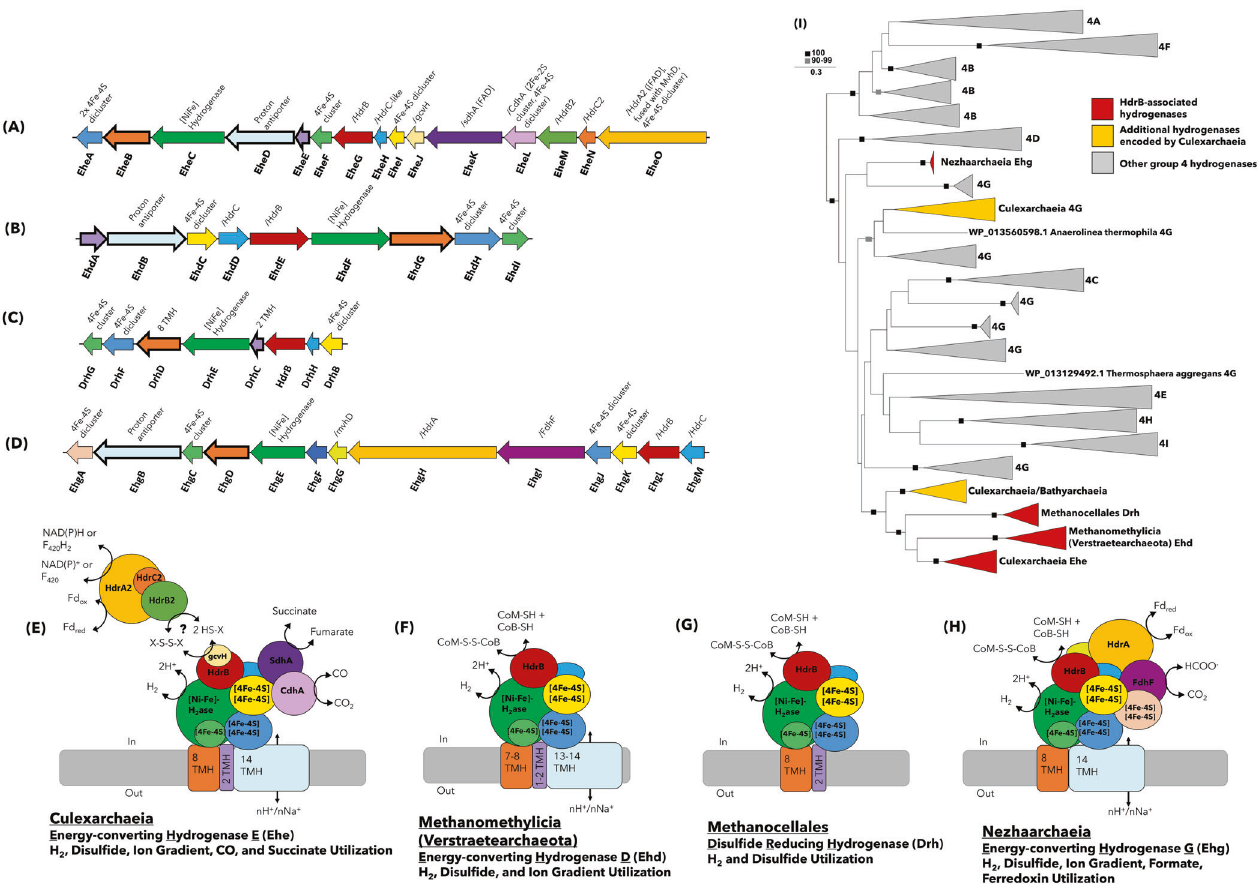
Fig. 4 Modular HdrB-interacting [NiFe] Hydrogenases present in Culexarchaeia, Methanomethylicia (Verstraetearchaeota), Methano- cellales, and Nezhaarchaeia. A , E Gene structure and tentative model of the Ehe complex proposed for Culexarchaeia, B , F Ehd complex proposed for Methanomethylicia (Verstraetearchaeota) (modi fi ed after [70]), C , G Drh complex proposed for Methanocellales, and D , H Ehg complex proposed for Nezhaarchaeia. Transmembrane helices (TMH) were predicted using TMHMM and sequences in A – D with TMHs are indicated with a thick border. Sequences that share a similar structural/functional role in these complexes are indicated with the same color. I Maximum-likelihood phylogenetic reconstruction of the catalytic subunit of group 4 [NiFe]-hydrogenases. Ehe, Ehd, Drh, and Ehg clades are displayed in red. Additional Culexarchaeia sequences belonging to group 4 [NiFe]-hydrogenases are labeled in The phylogenetic placement of Culexarchaeia aids in recon- structing the evolutionary history of TACK archaea. Particularly, tionary transitions between methanogenic and non- methanogenic lineages. Currently, the evolution of the WLP as Table 2. Candidatus Culexarchaeia class nov.